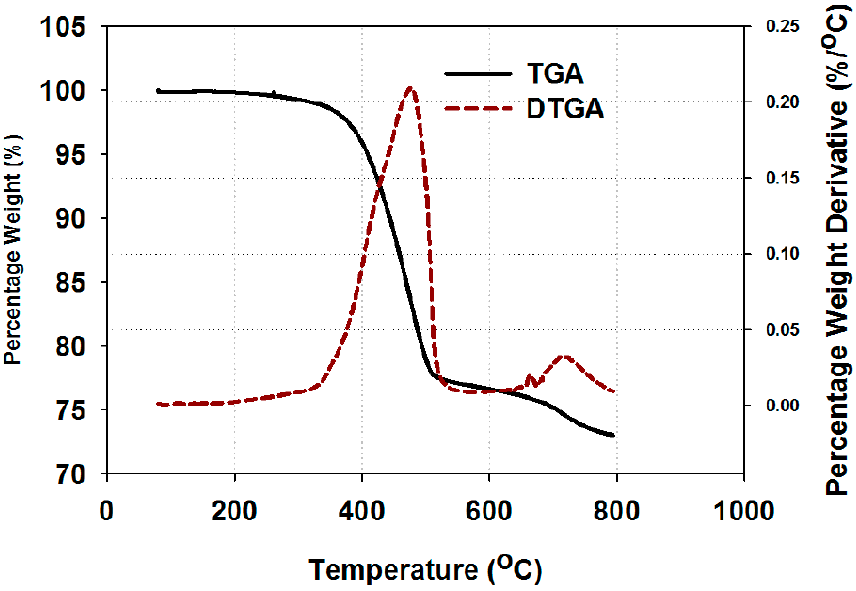
Figure 5. TGA-DTGA of RTV silicone rubber filled with MH to 50 wt.%, performed in Nitrogen atmosphere under a temperature ramping protocol between 80 and 800 °C at a rate of 10 °C/min.